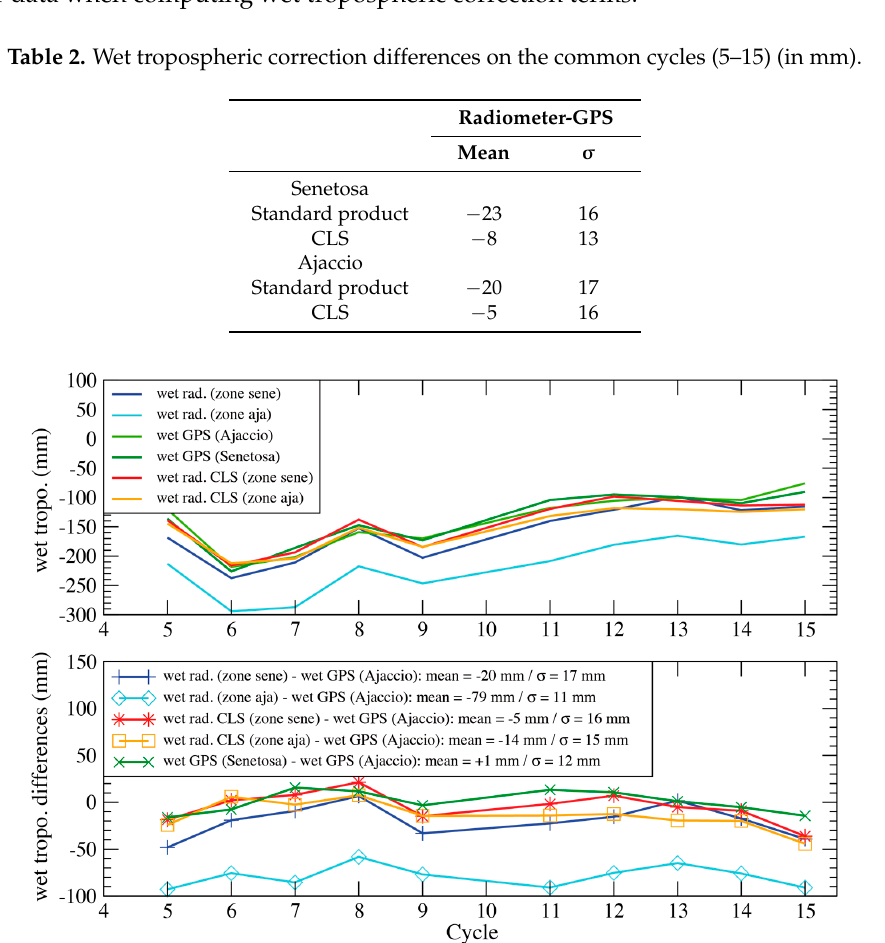
Figure 4. Sentinel-3A wet tropospheric correction differences at Ajaccio (using the Ajaccio interpolation area). Wet tropospheric correction in the upper panel: derived from satellite microwave radiometer using the Senetosa interpolation area (dark blue), radiometer using the Ajaccio interpolation area (light blue), GPS from Ajaccio (light green), GPS from Senetosa (dark green), radiometer (from Collecte Localisation Satellites (CLS)) using the Senetosa interpolation area (red) and radiometer (from CLS) using the Ajaccio interpolation area (orange). Wet tropospheric correction differences in the lower panel: reference is always the wet tropospheric correction from the Ajaccio GPS and same color code is used for the corrections being compared.